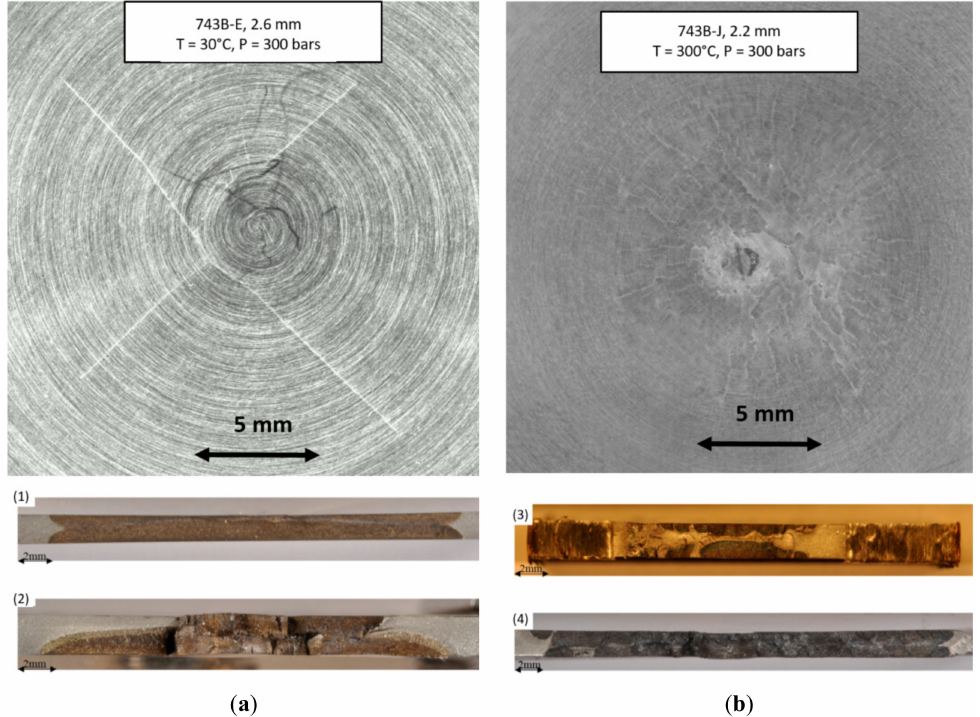
Figure 13. View of the fatigue crack initiation on the spherical bending specimen ( a ) without the water effect (at 30 ◦ C) and ( b ) with the water effect (at 300 ◦